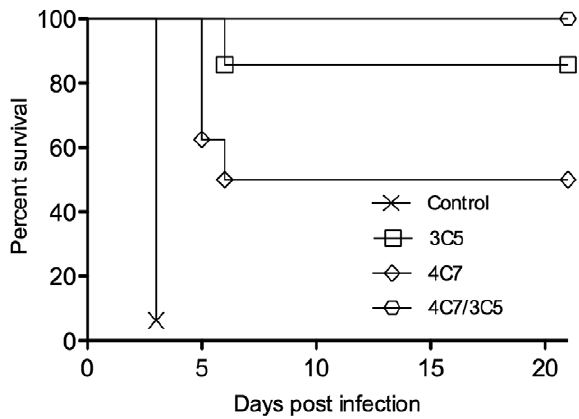
Figure 1. Protection in passively immunized mice following i.n. challenge with B.pseudomallei strain 1026b. BALB/c mice were administered 1 mg of either CPS IgG3 mAb 3C5 or LPS IgG3 mAb 4C7 alone or 1 mg of each mAb in combination by the i.p. route. Intranasal challenge was performed 18 h later with 15 LD 50 of B. pseudomallei . Mice were monitored for 21 days after which gross pathology and spleen cfu were determined on survivors (Table 1). Control mice were treated with 1 mg of an irrelevant IgG3 mAb. p values of survival vs. controls are listed in Table 1.